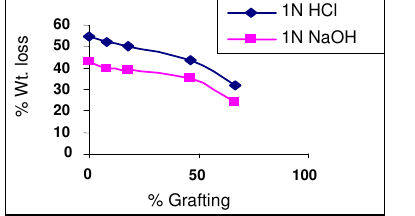
Figure 5. Effect of chemicals on graft copolymers